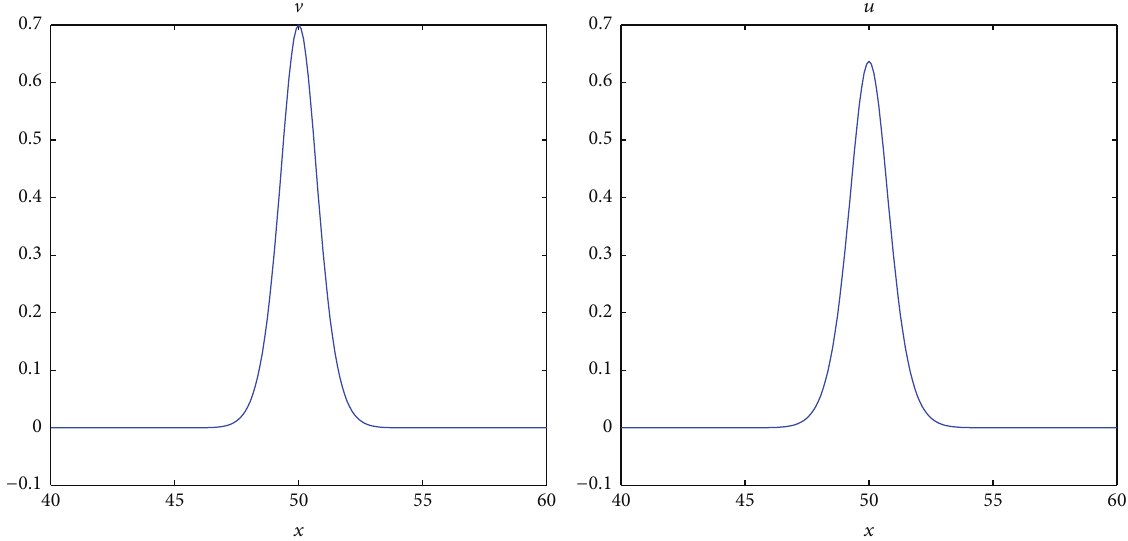
Figure 7: Solitary wave solution of system (75) for 𝛼 = 𝛽 = 0.3 , 𝜎 = 0.3 , and wave speed 𝑐 = 1.1 , obtained after 5 Newton’s